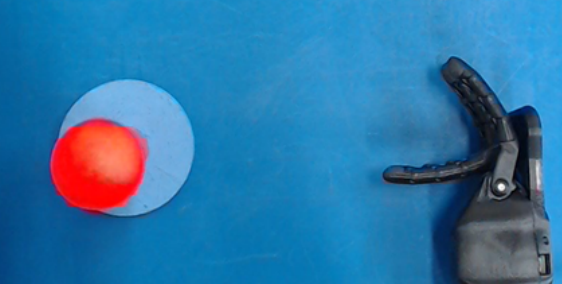
Figure 10: The image obtained from the top-mounted camera in the NICO experimental setup.